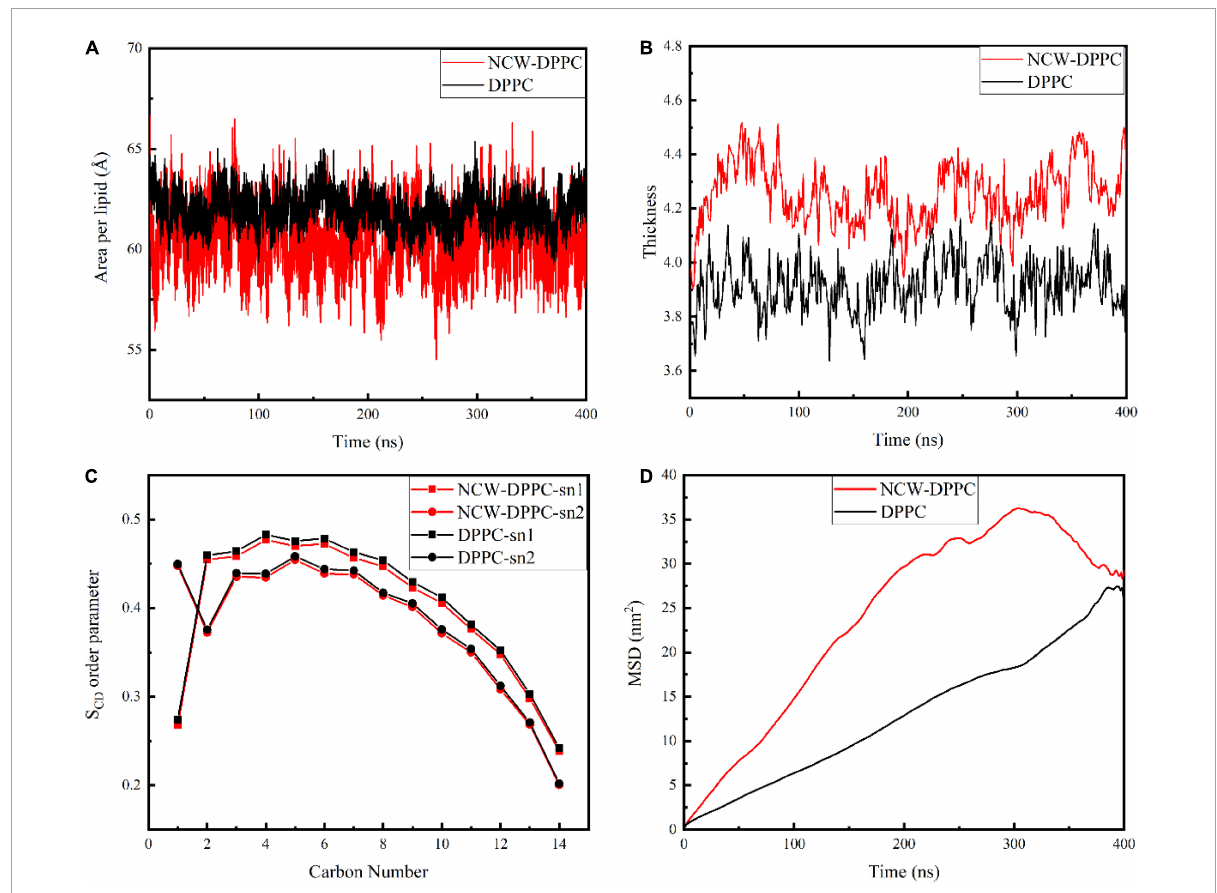
FIGURE3 The effect of tripeptide NCW on the thickness (A) , area per lipid (B) , order parameter of sn1 and sn2 chains (C) , and MSD (D) of DPPC membrane over the simulation.